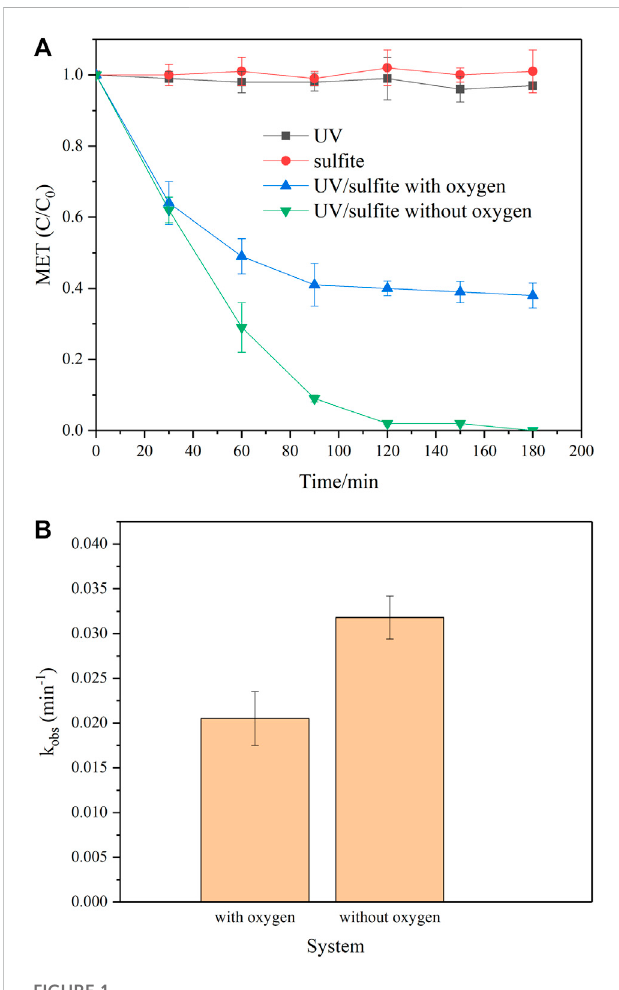
FIGURE 1 (A) MET degradation ef fi ciency in different reaction processes; (B) Pseudo fi rst-order rate constants for MET degradation with or without oxygen by the UV/sul fi te process. Experimental conditions: [MET] 0 = 10 mg/L, [SO 3 2- ] 0 = 10 mM, pH =